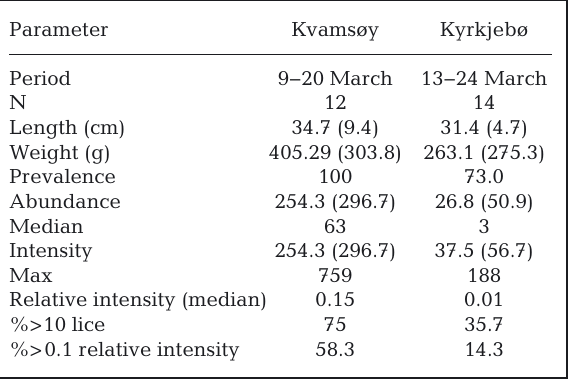
Table 1. Salmon lice Lepeophtheirus salmonis infestation para meters for sea trout Salmo trutta sampled at Kvamsøy and Kyrkjebø, Norway, in March 2014. Prevalence: percent- age of fish infected in the sample; abundance: average num- ber of salmon lice in all sampled fish; intensity: average num- ber of salmon lice in infected fish; max: maximum number of lice recorded on a fish; relative intensity is lice per gram fish; %>10 lice: percent of fish with more than 10 lice; %>0.1 rela- tive intensity: percent of fish with a relative intensity >0.1. Values in parentheses indicate SD